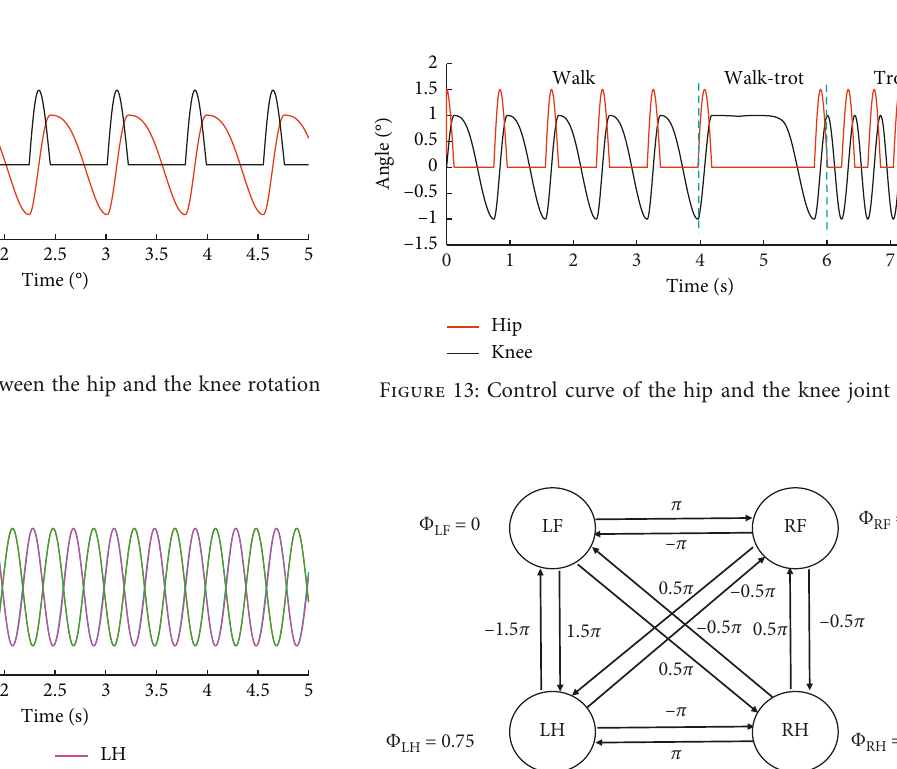
Figure 8: Phase relationship of the hip joint in the walk gait.